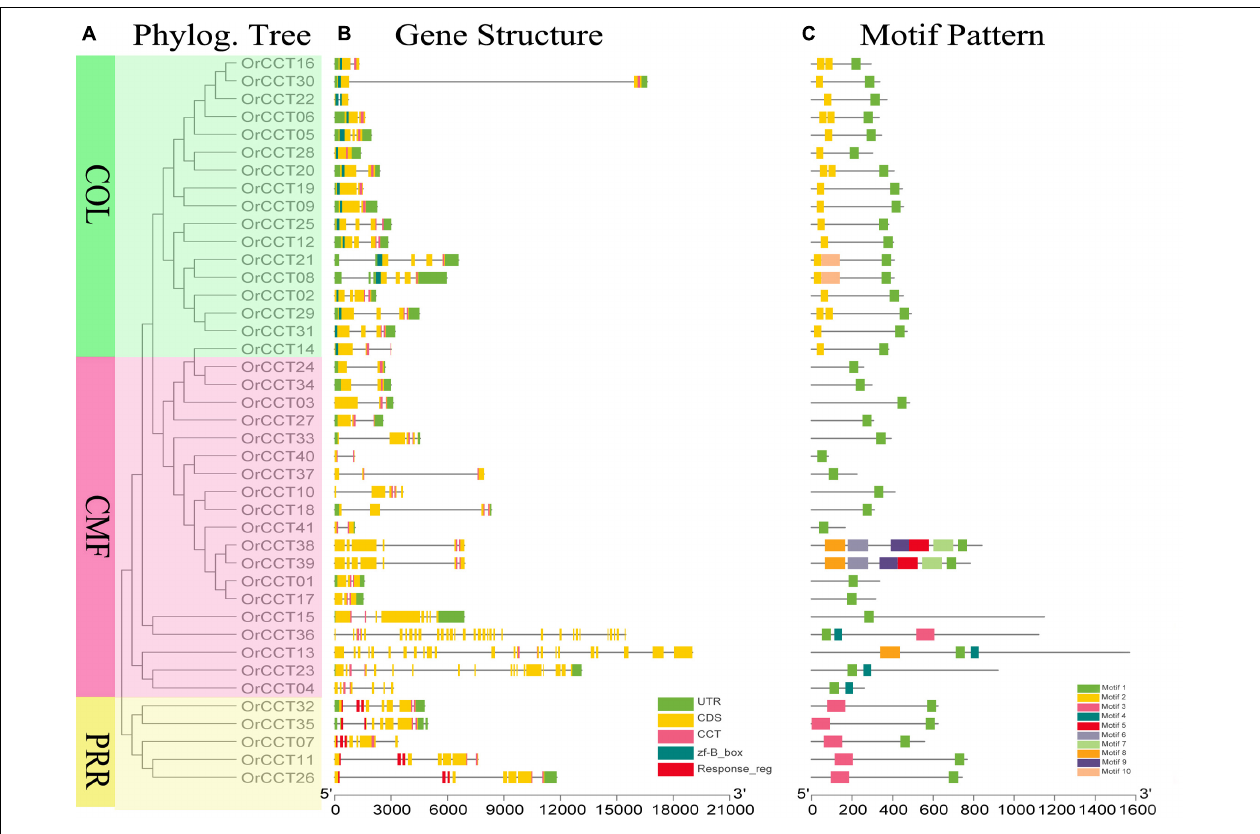
FIGURE 1 | Phylogenetic relationship, gene structure, and conserved motifs of OrCCT TFs in O. rufipogon . (A) Phylograms of OrCCT TFs were constructed based on the full-length protein sequences. Different subfamilies are highlighted with different colors. PRR in yellow, COL in green, and CMF in red. (B) Exon-intron structure and conserved domains of OrCCT TFs. (C) The motif patterns of OrCCT proteins. The sequence information for each motif is given in Supplementary Table 3